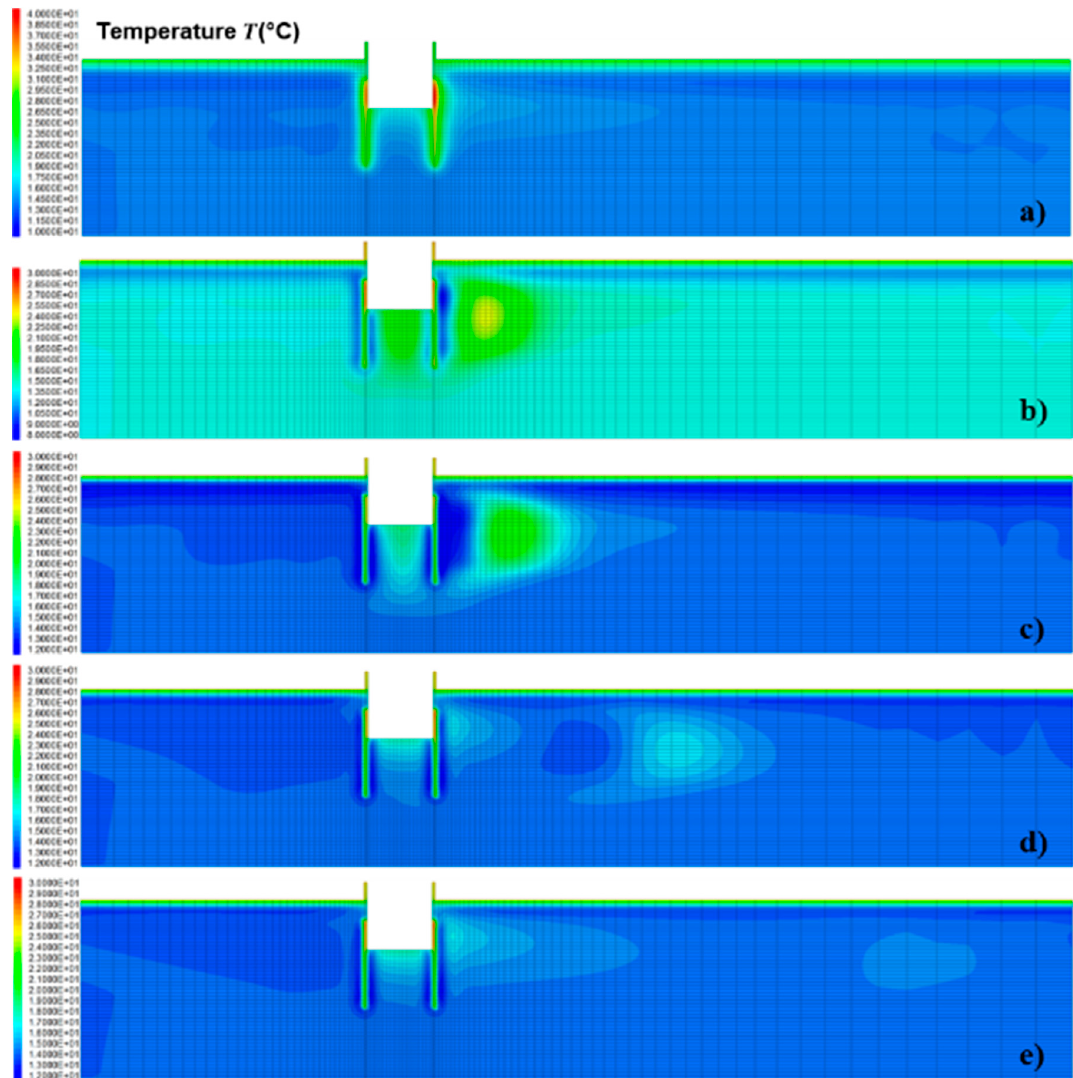
Figure 7. Temperature contour after some years of thermal exploitation: ( a ) one year; ( b ) two years; ( c ) five years; ( d ) 10 years; ( e ) 20 years.